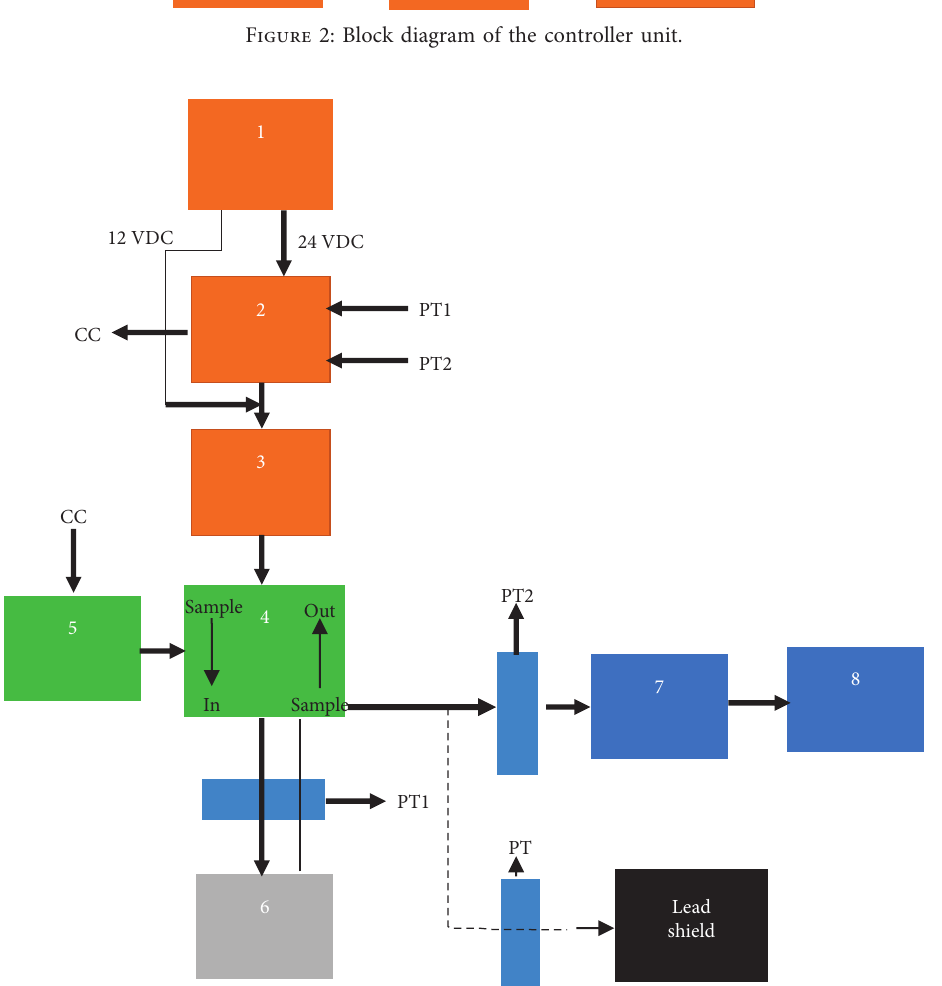
Figure 3: Flow chart for cyclic mode analysis with the conventional mode option.